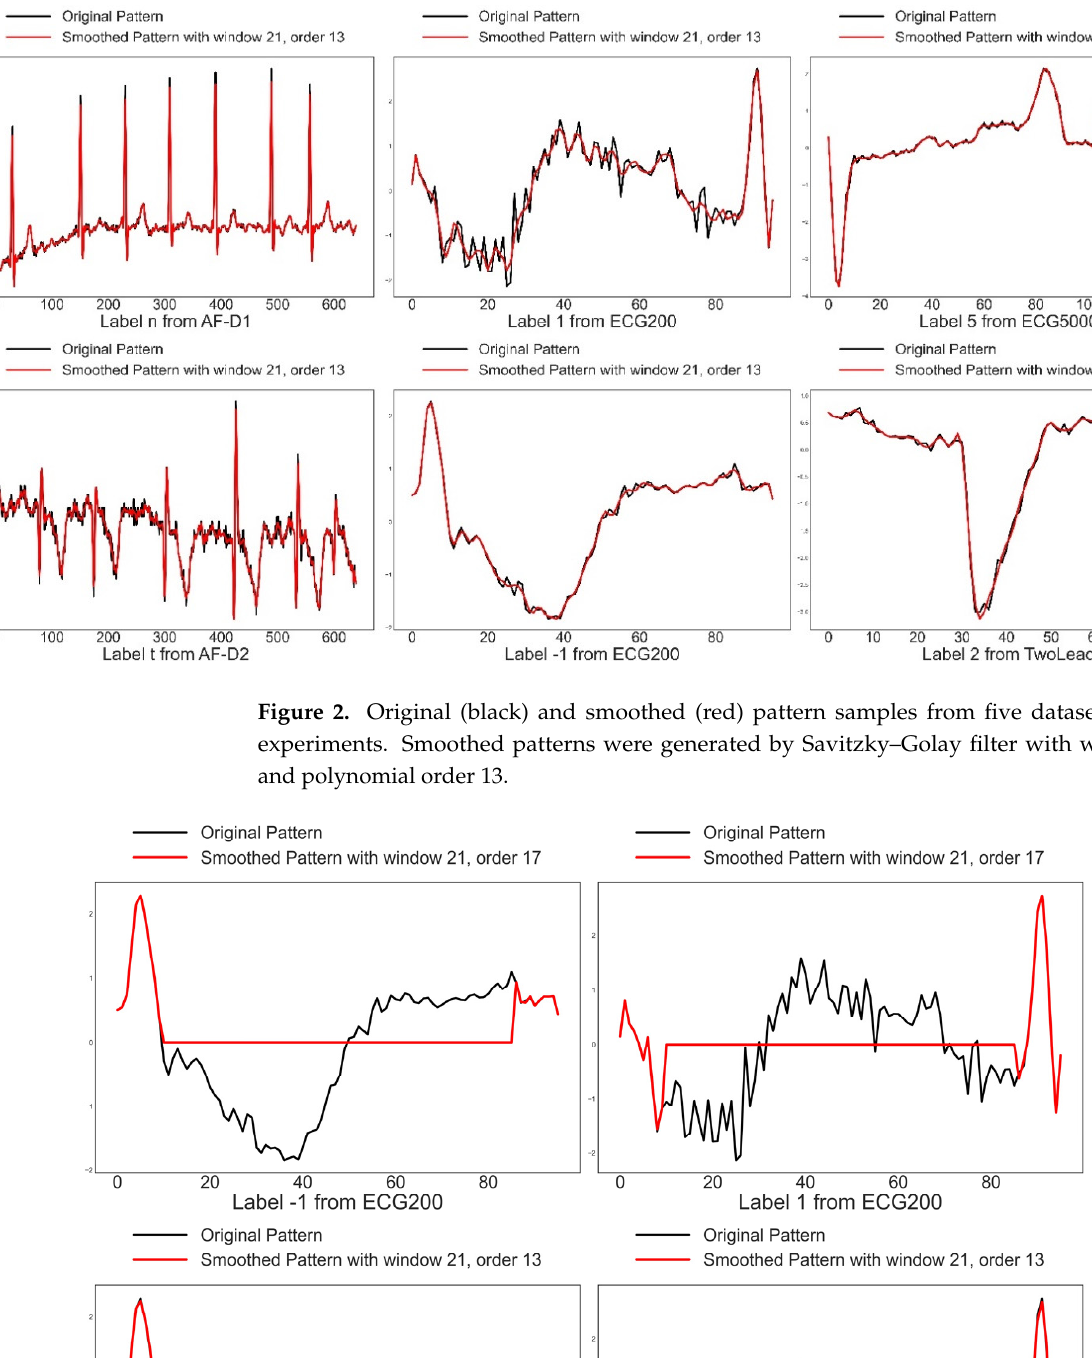
Figure 3. Smoothing effects according to the polynomial orders of Savitzky–Golay filter. The window size was fixed at 21 and polynomial orders were applied to the 2 sample patterns from the ECG200 dataset in the order of 17, 13, 5, and 3, from top to bottom in the figure.